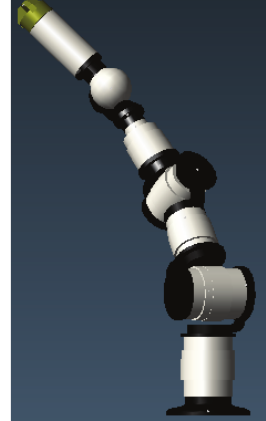
Figure 1: CAD model of the anthropomorphic arm.